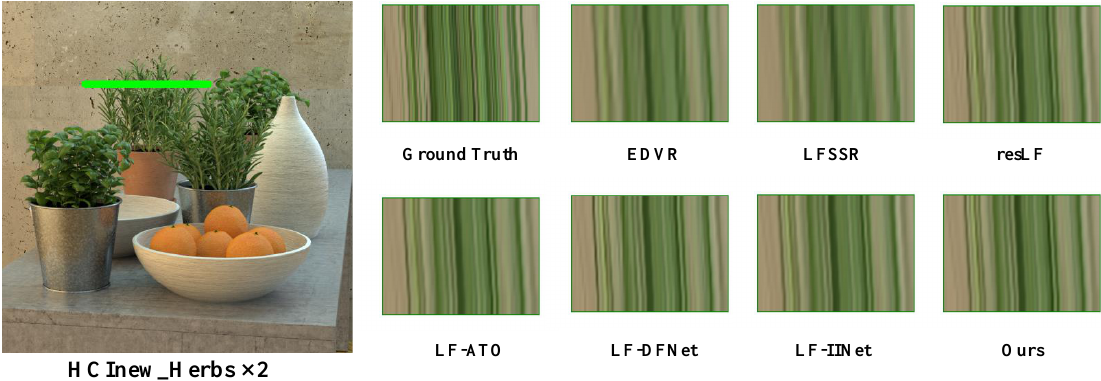
Figure 11. Visual results of EPIs.